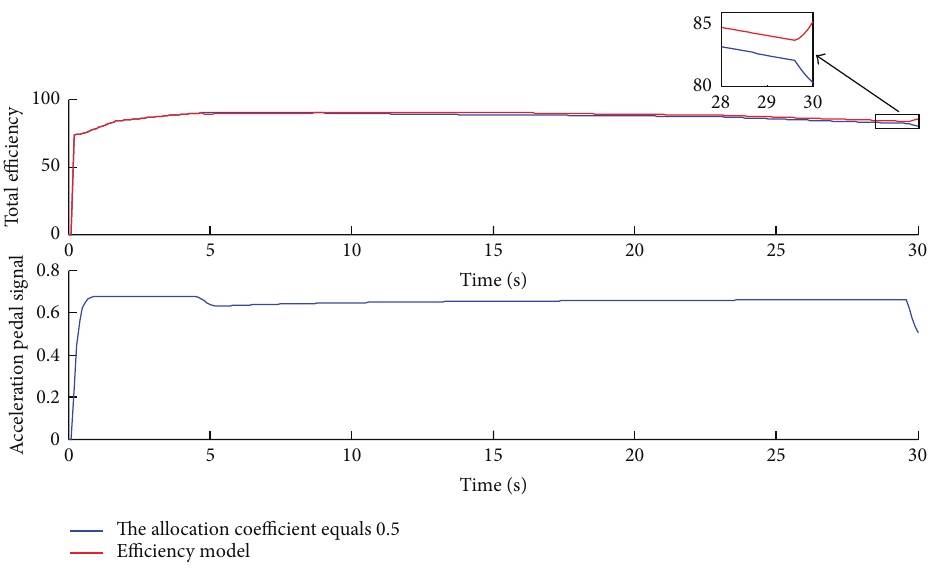
Figure 18: The time history of the total efficiency and 𝐴